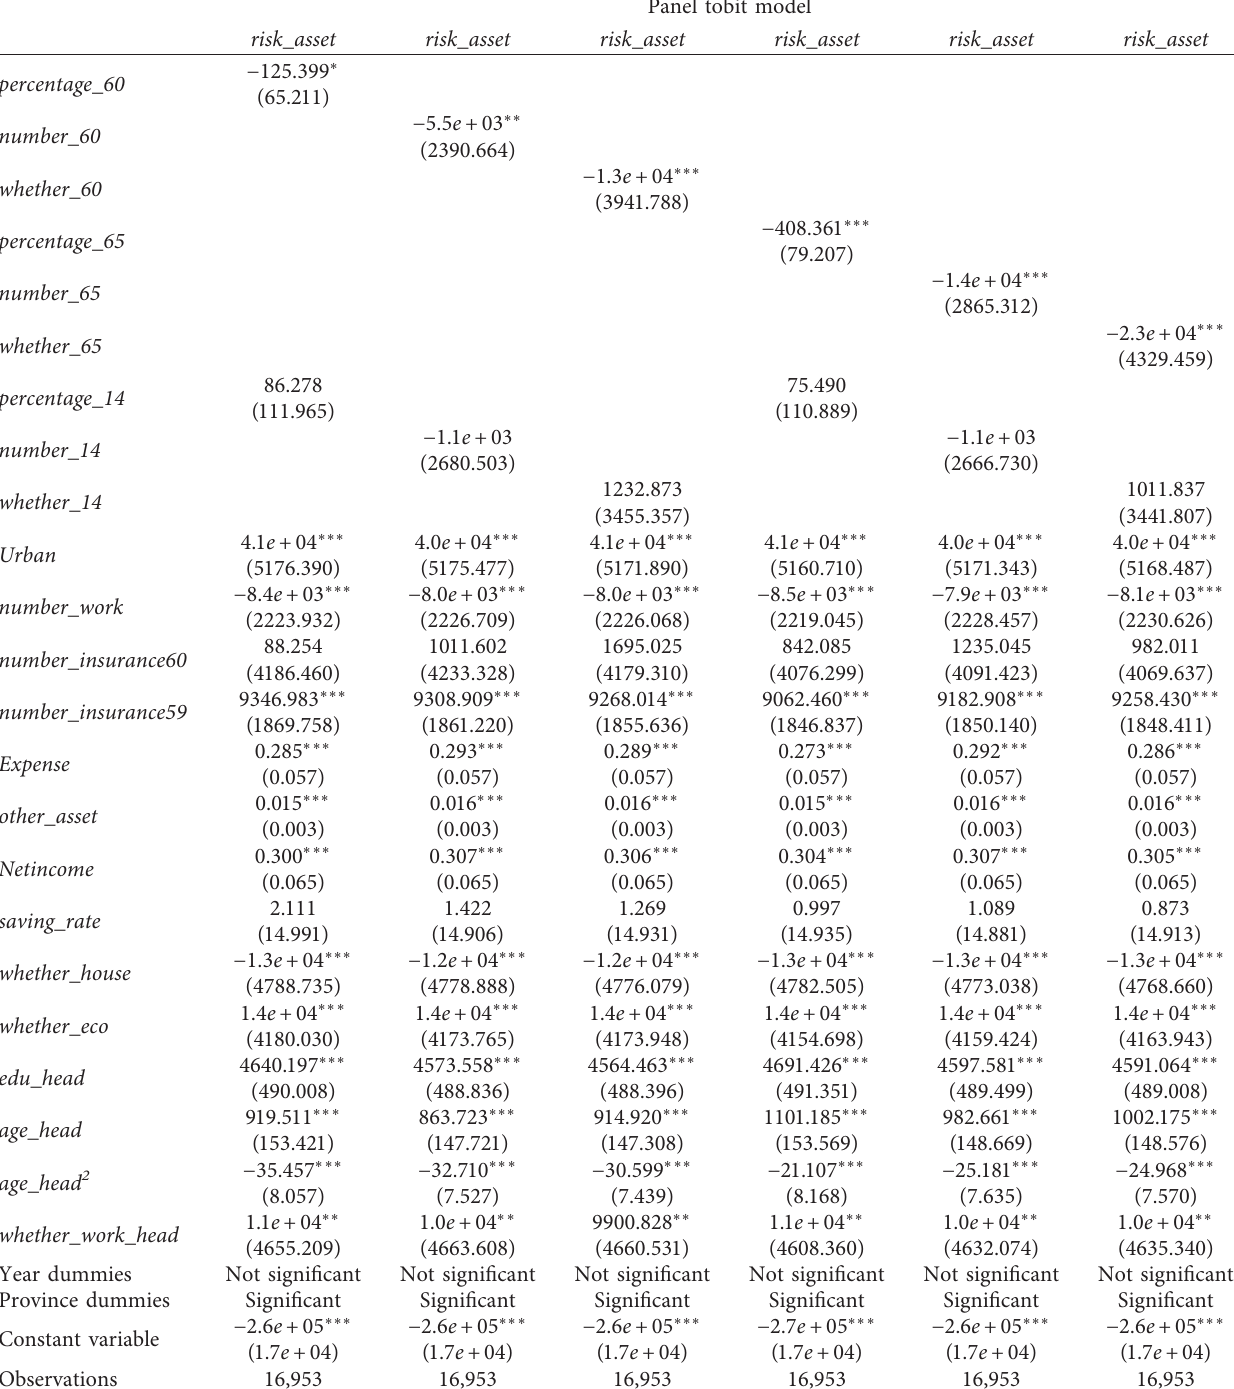
Table 6: Results on the scale of families’ risky assets